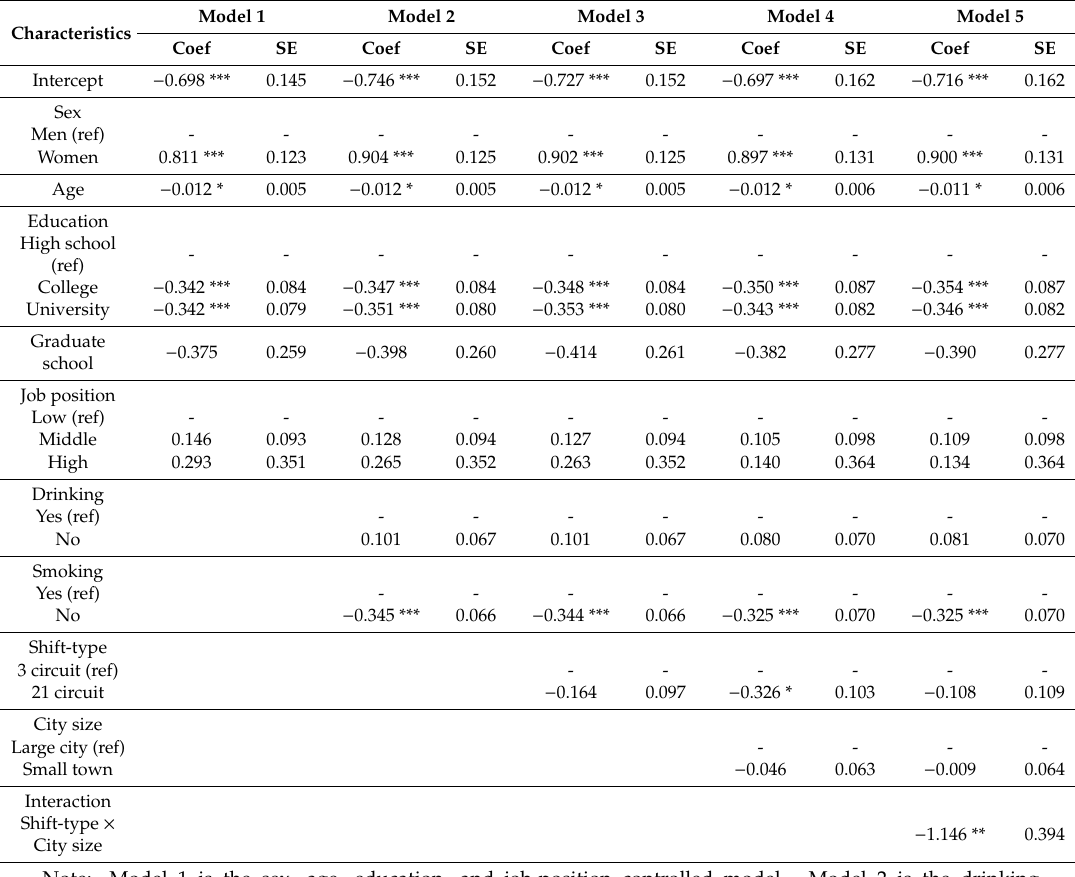
Table 2. Logistic regression models examining the relationships between variables and exercise training (N = 4653).